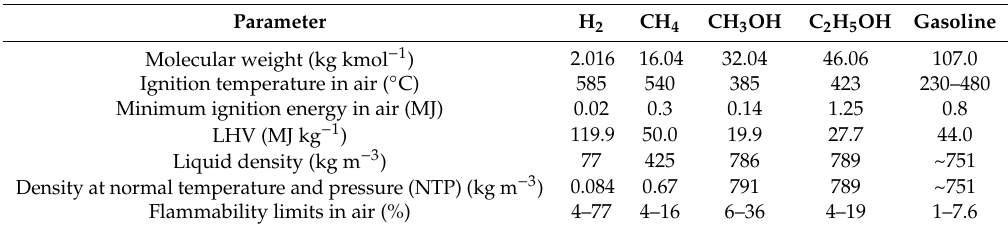
Table 1. Basic chemical and physical data on hydrogen, methane, methanol, ethanol, and gasoline, adapted from